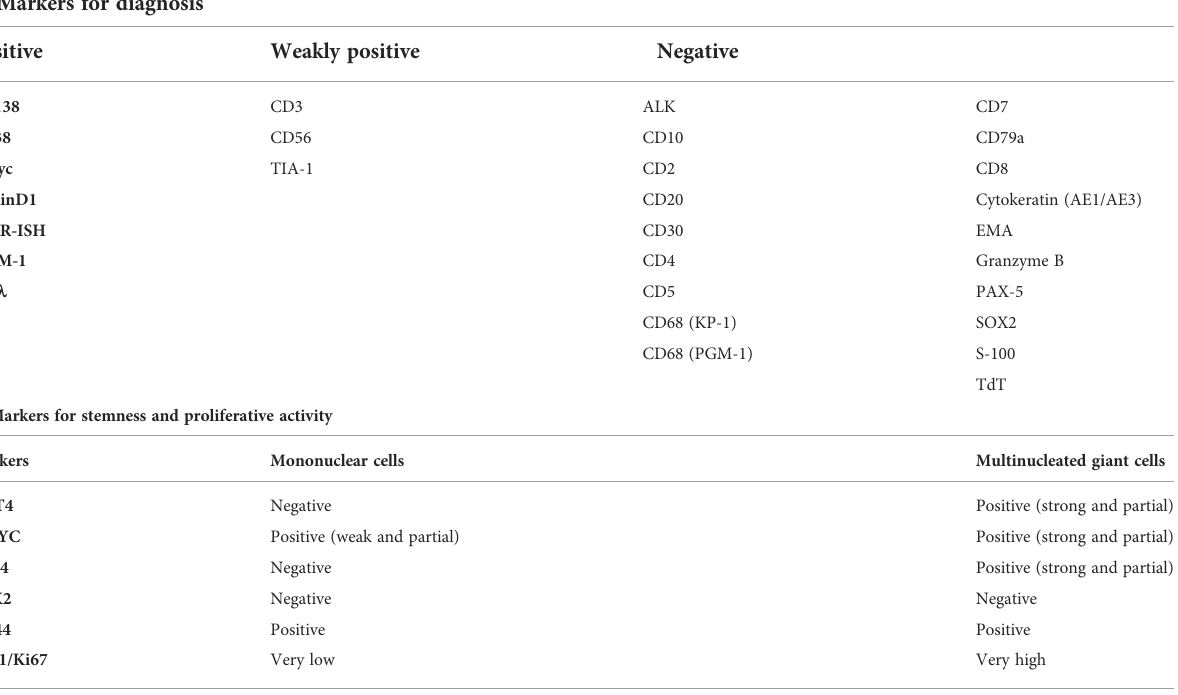
TABLE 1 Immunohistochemistry and in situ hybridization